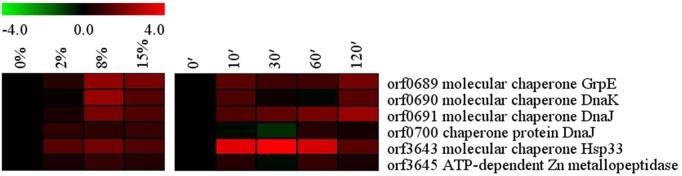
Alterations in molecular chaperones related genes.Expression profiles are displayed on the basis of log2 ratios.